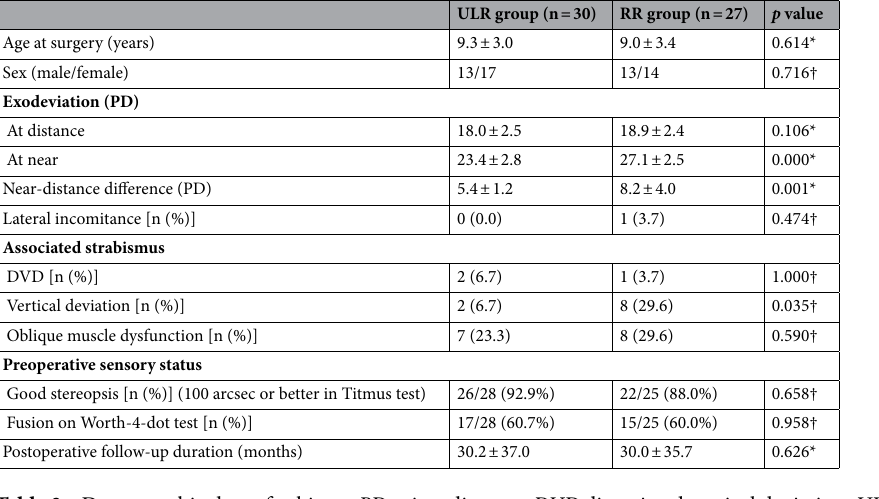
Table 2. Demographic data of subjects. PD prism dioptres, DVD dissociated vertical deviation, ULR group patients who underwent unilateral lateral rectus recession, RR group patients who underwent unilateral